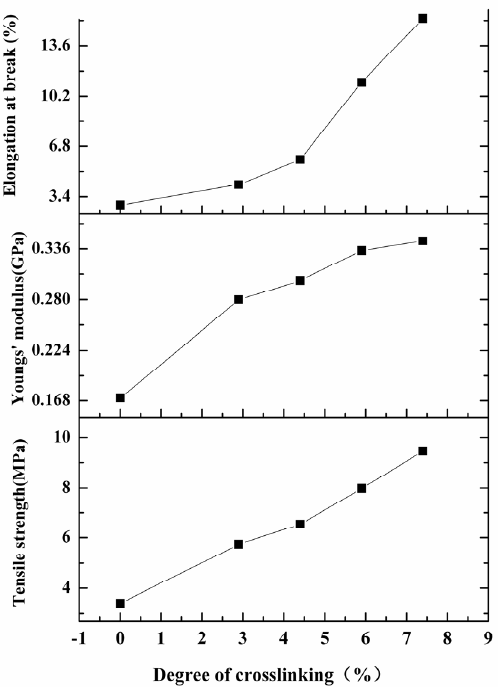
Figure 4. Mechanical properties of N -phthaloyl acylated chitosan with different crosslinking